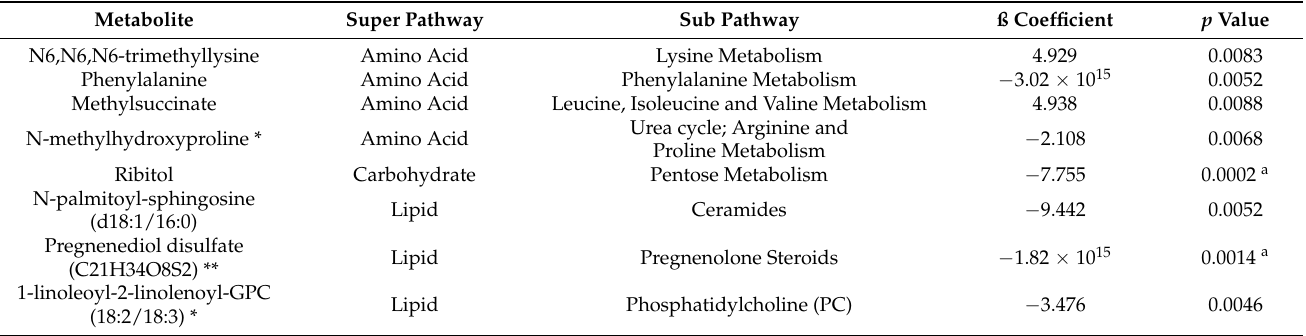
Table 2. Baseline metabolites associated with progression of AMD based on color fundus photographs ( p <